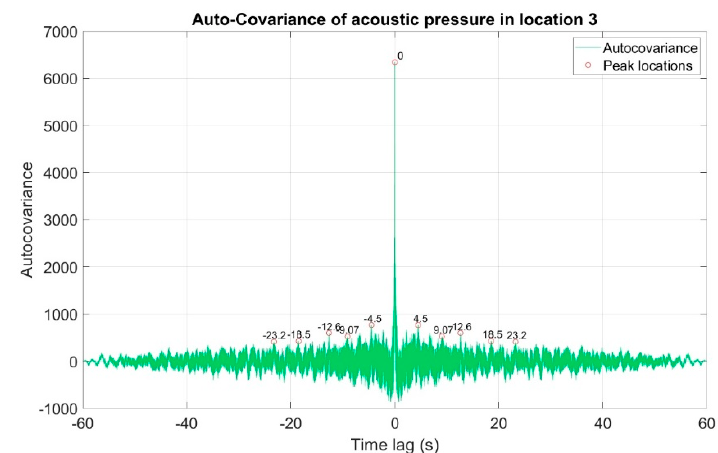
Figure 12. Course of auto-covariance function of infrasound signals generated by the investigated wind turbine, recorded in measuring setup number 3.